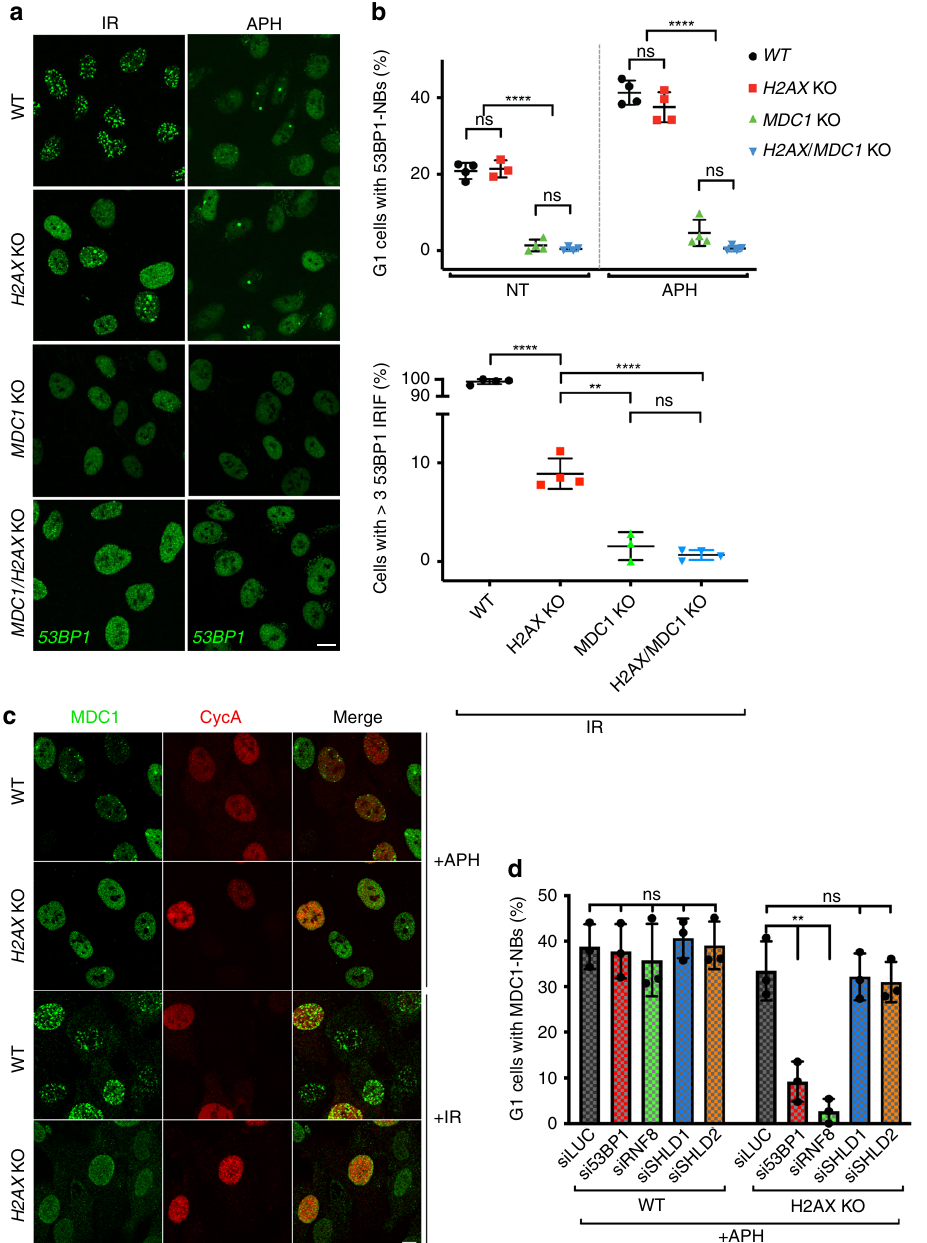
Fig. 2 53BP1 localisation to DNA-damage sites in H2AX − / − cells depends on MDC1. a Representative immuno fl uorescence images of 53BP1 NB formation after 24 h of 0.4 μ M aphidicolin (APH) treatment, and of 53BP1 IRIF 1 h after IR (3 Gy) exposure in wild-type RPE-1 and knockout cell lines. b Quanti fi cation of 53BP1-NBs and 53BP1 IRIF in cells treated as in a . Cyclin A staining was used to differentiate G1 from S/G2 cells; n = 4/genotype (except for non-treated H2AX KO and IR MDC1 KO n = 3); error bars s.e.m.; **** p < 0.0001; two-tailed Student ’ s t test. c Representative immuno fl uorescence images showing MDC1 localisation at NBs or IRIF after APH or IR treatments (as in a ) in the RPE-1 H2AX + / + and H2AX − / − cell lines. Cyclin A staining was used to distinguish between G1 and S/G2 cells. d Quanti fi cations showing MDC1 localisation at NBs in the RPE-1 H2AX + / + and H2AX − / − cell lines after 24 h treatment with 0.4 μ M APH. Cells were depleted for 53BP1, RNF8, SHLD1 or SHLD2 by siRNA for 48 h before the APH treatment; n = 3/genotype; error bars s.e.m.; ** p < 0.01; two-tailed Student ’ s t test. Supporting data, including quanti fi cations of number of NBs and IRIF per cell and validation of 53BP1, RNF8, SHLD1 and SHLD2 depletion are shown in Supplementary Fig. 2. Scale bars, 10 μ